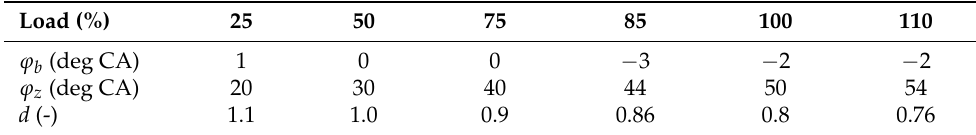
Table 6. The Wiebe parameters according to the SL model in gas fuel mode.